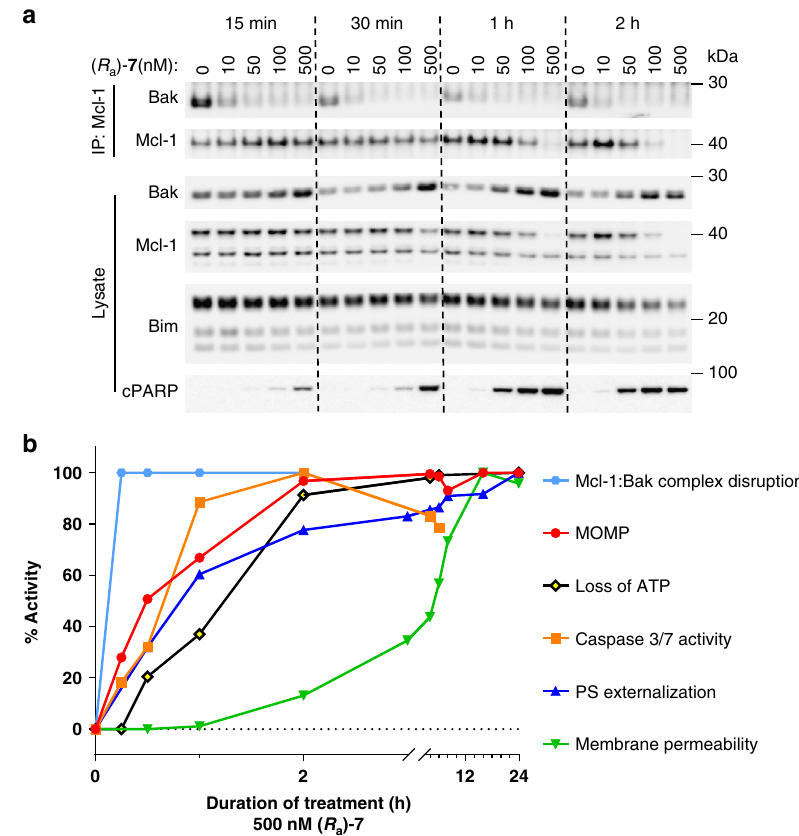
Fig. 4 Kinetics of apoptosis and cell death induction by ( R a )- 7 . a Whole cell extract (bottom) and IP (top) of Mcl-1 from lysates of MOLP-8 cells treated with ( R a )- 7 at indicated concentrations followed by immunoblot analysis. b Summary of the kinetic of ( R a )- 7 effect on Mcl-1:Bak complex disruption, MOMP, cellular loss of ATP, caspase-3/7 activity, phosphatidyl-serine externalization and cell membrane permeability in MOLP-8 cells upon treatment with ( R a )- 7 at 500 nM. Representative data of two independent experiments are